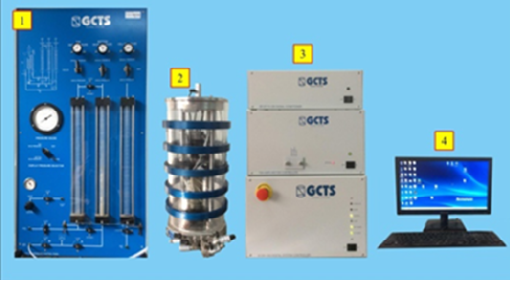
Figure 2. Schematic diagram of TSH-100 resonant column apparatus.